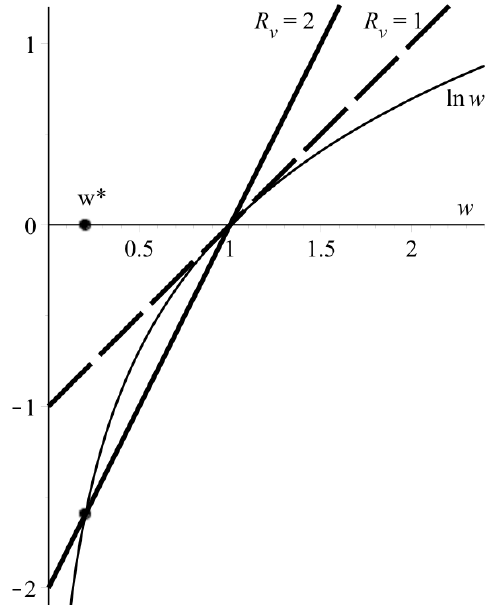
Figure 3. Graphical solution to Equation (8a) for two R v values. Thin line—ln w , bold lines— R v · ( w − 1 )